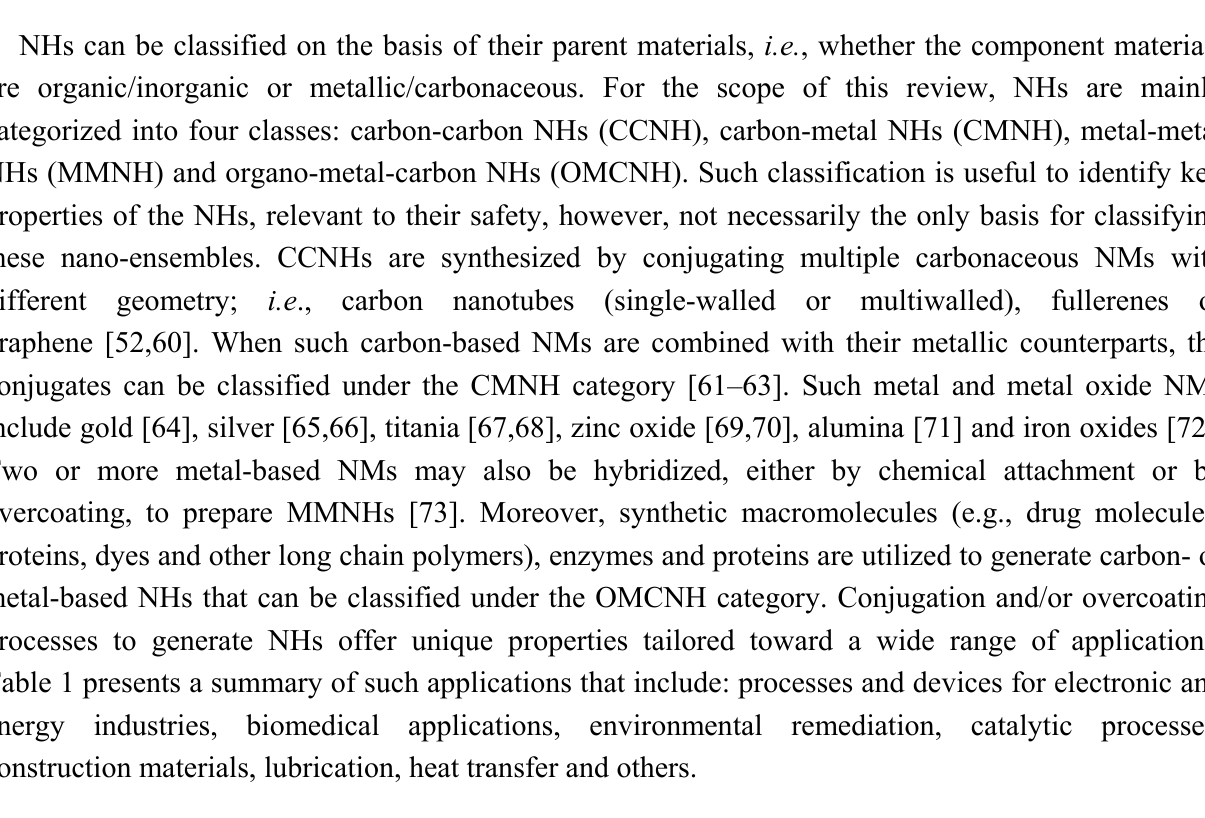
Table 1. Types and current applications of nanohybrid